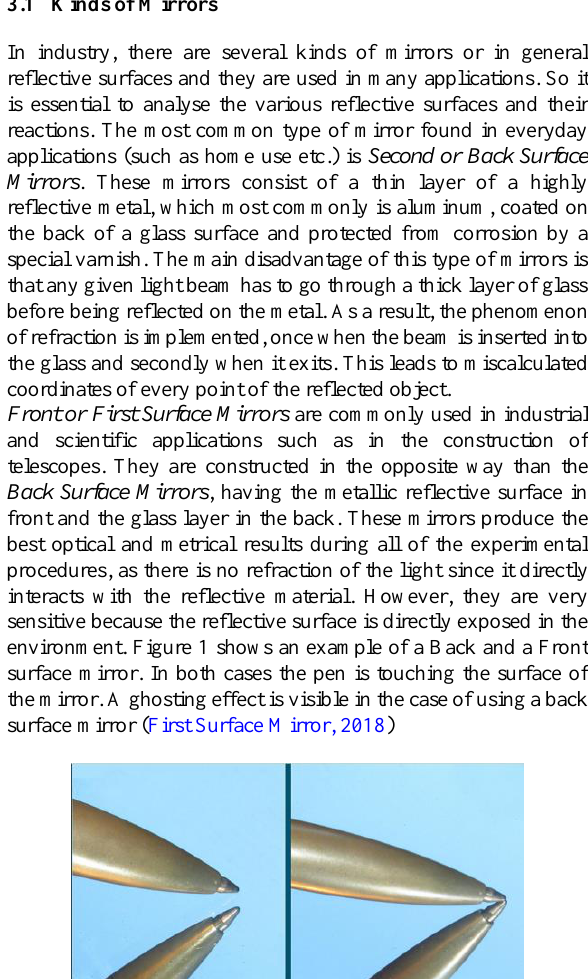
Figure 3: The mirror does not change the size of the original